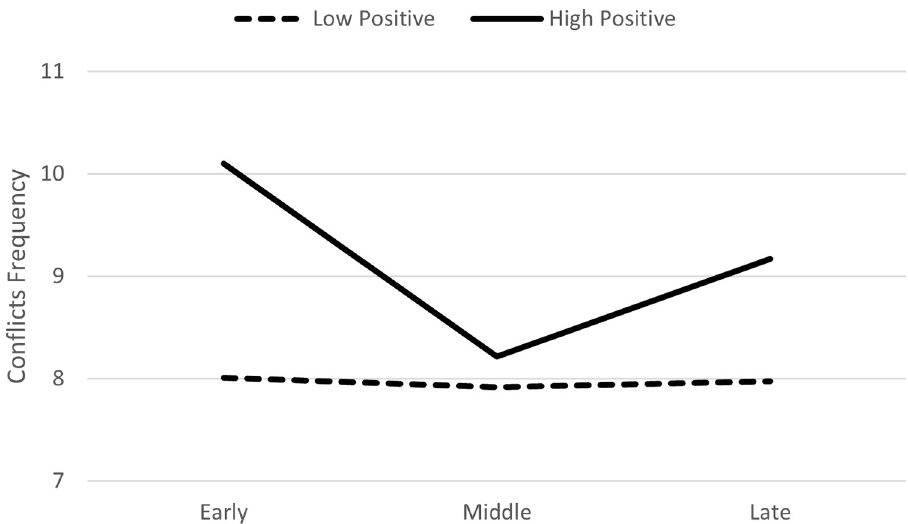
Fig 3. Change over time in frequency of conflicts as function of positive actions in the first phase of the relationship.